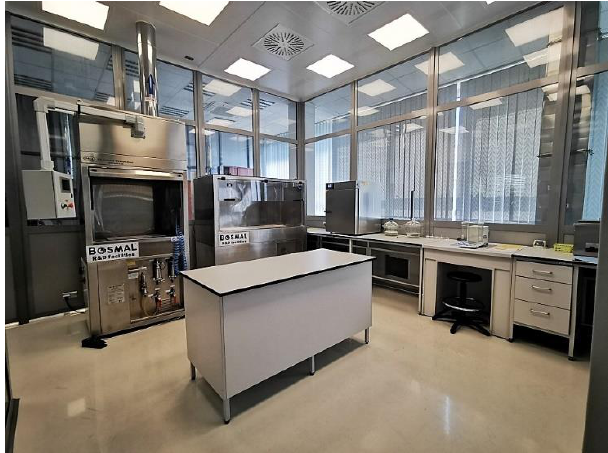
Fig. 1. BOSMAL’s ISO 6 class cleanroom equipped with pressure rinsing equipment, ultrasonic bath, analytical balance, temperature chamber and filtration